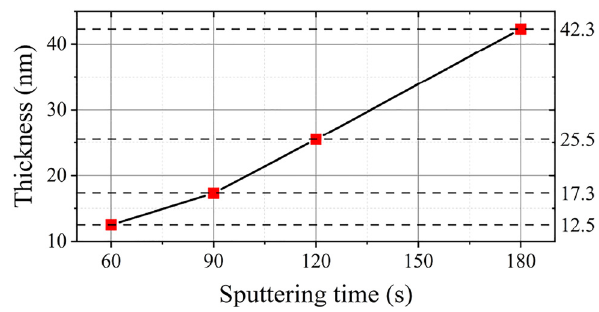
Figure 6: Relationship between gold film thickness and sputtering duration.